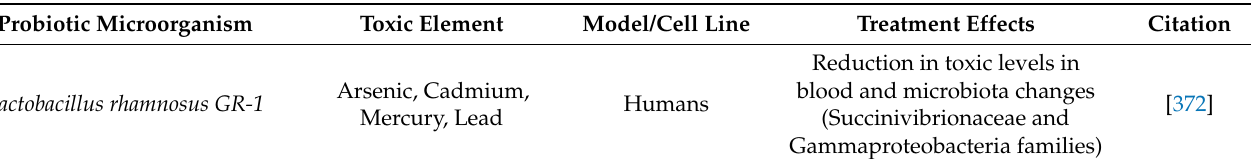
Table 3. Gut microbial interactions with metals, both antagonistic and